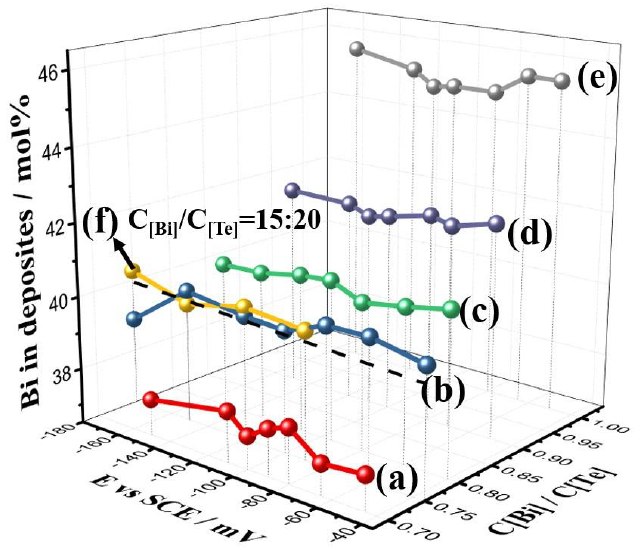
Figure 2. Elemental composition of the deposits for different electrolyte concentrations and deposition potentials.